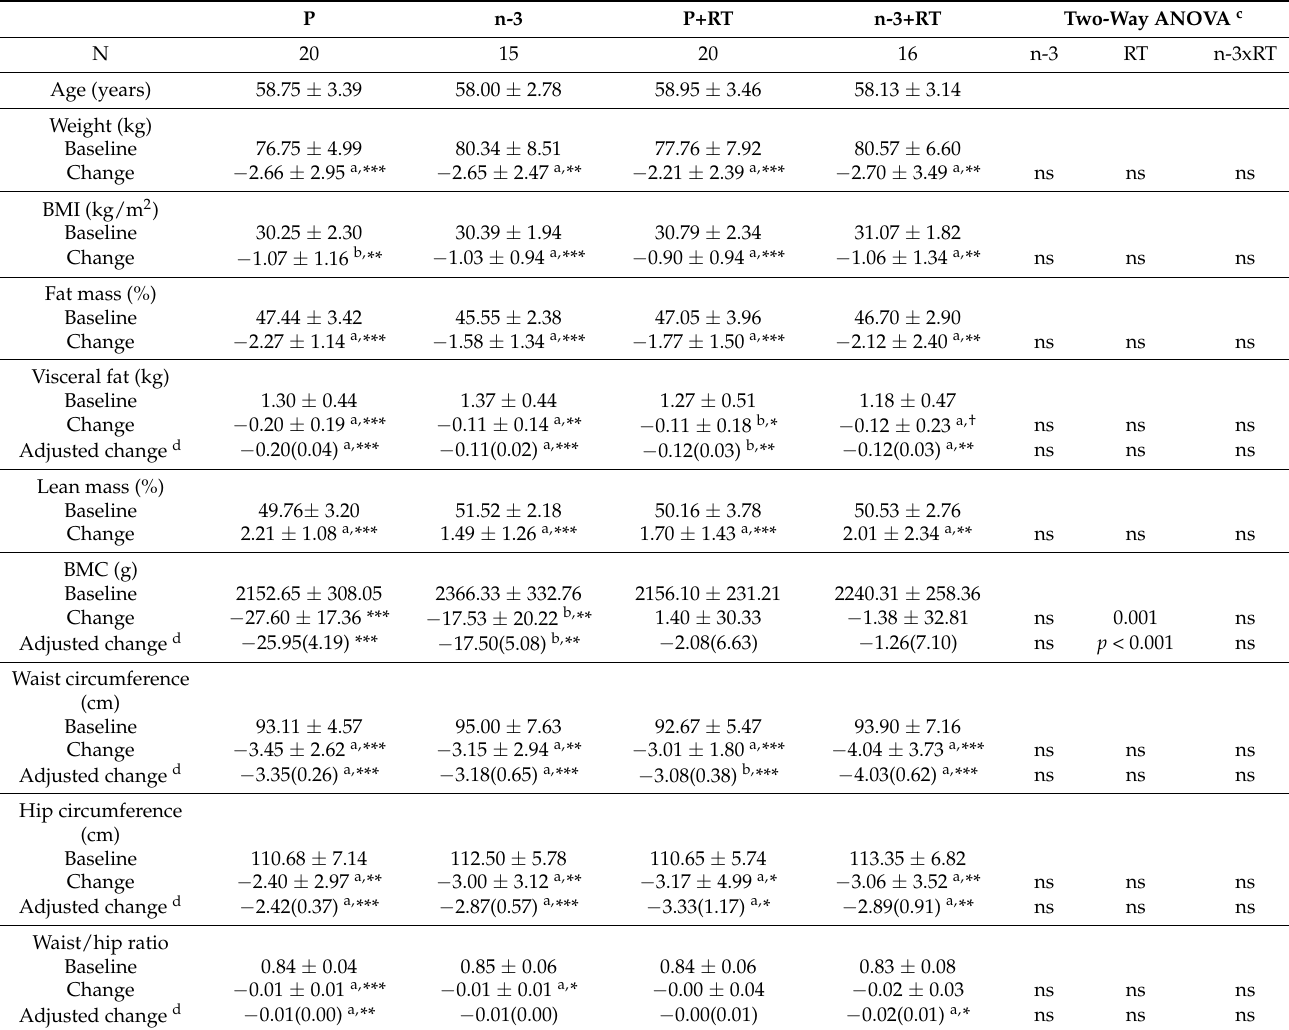
Table 1. Effects of 16 weeks of DHA-rich n-3 PUFA (n-3) supplementation and/or resistance training (RT) on whole body composition and anthropometric measures in overweight/obese post-menopausal